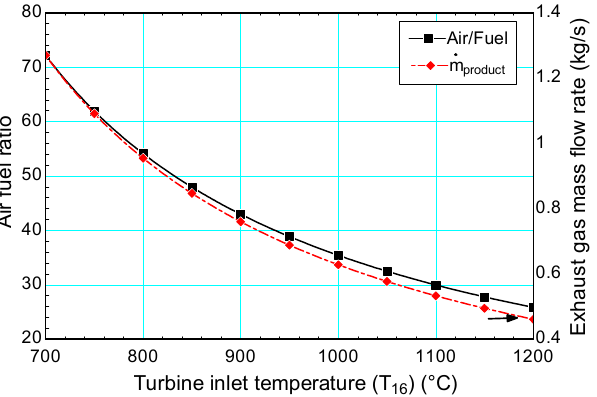
Figure 5. Turbine inlet temperature effect on air fuel ratio and exhaust gas mass flow rate.